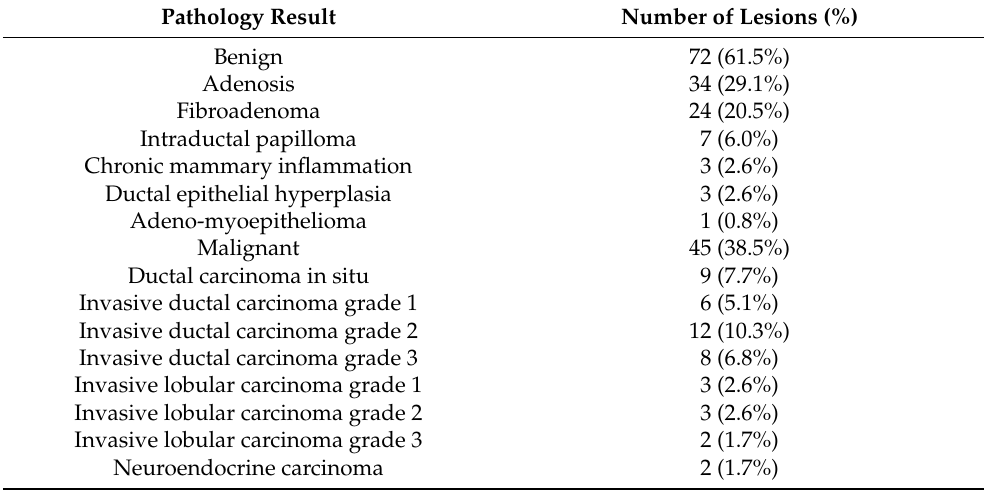
Table 2. Pathological Findings of lesions.